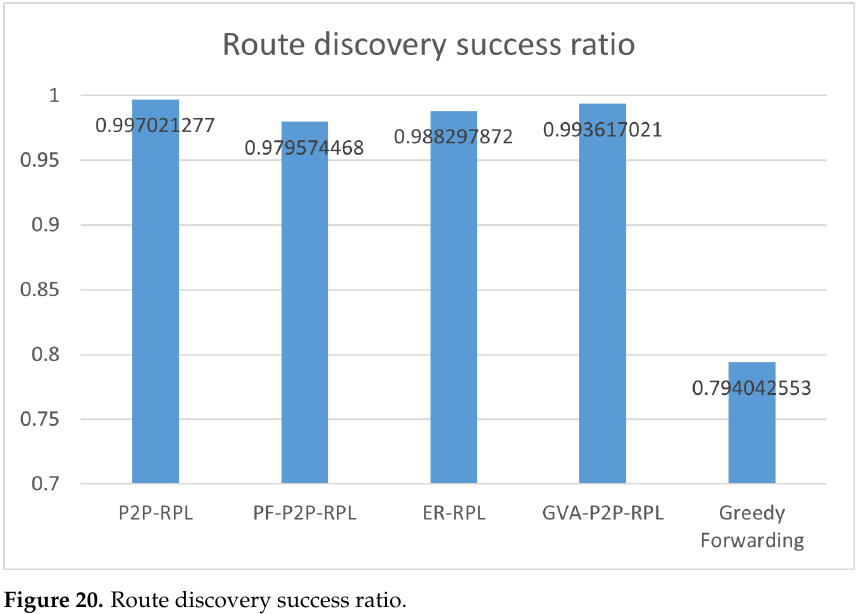
Figure 20. Route discovery success ratio.